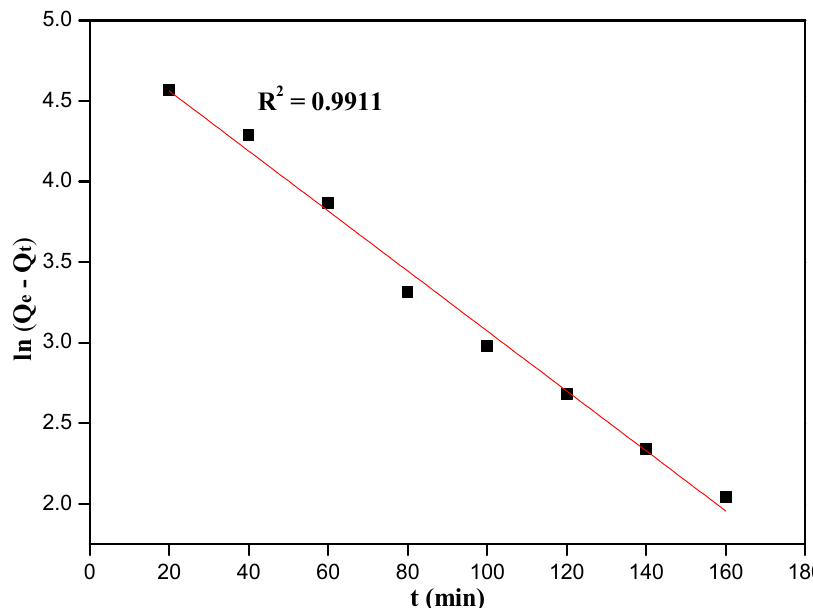
Figure 9. Fit of kinetic data to pseudo-first-order model.